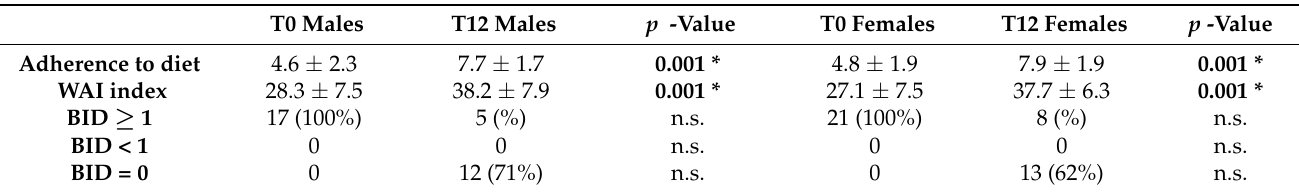
Table 3. Results of adherence to the Mediterranean diet, work ability index (WAI), and body image dissatisfaction (BID), at T0, T6, and